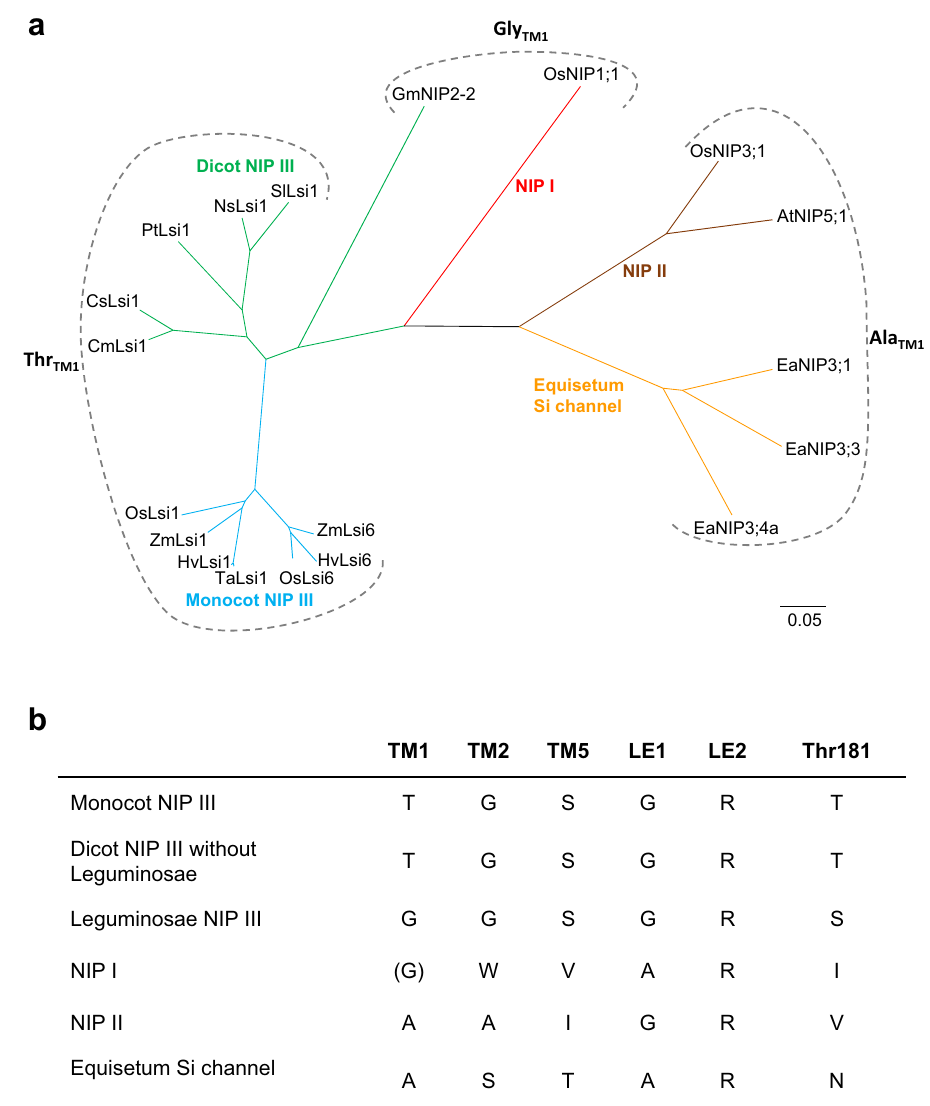
Fig. 8 Analysis of selectivity fi lters in NIP subfamilies. Phylogenetic tree of plant NIP subfamilies ( a ), and summary of the residues comprising the selectivity fi ler and Thr181 ( b ). The phylogenetic tree was constructed using the neighbor-joining algorithm by the software MEGAX 51 after the sequence alignment using Clustal Omega 52 with 1,000 bootstrap trials. The 0.05 scale indicates substitution